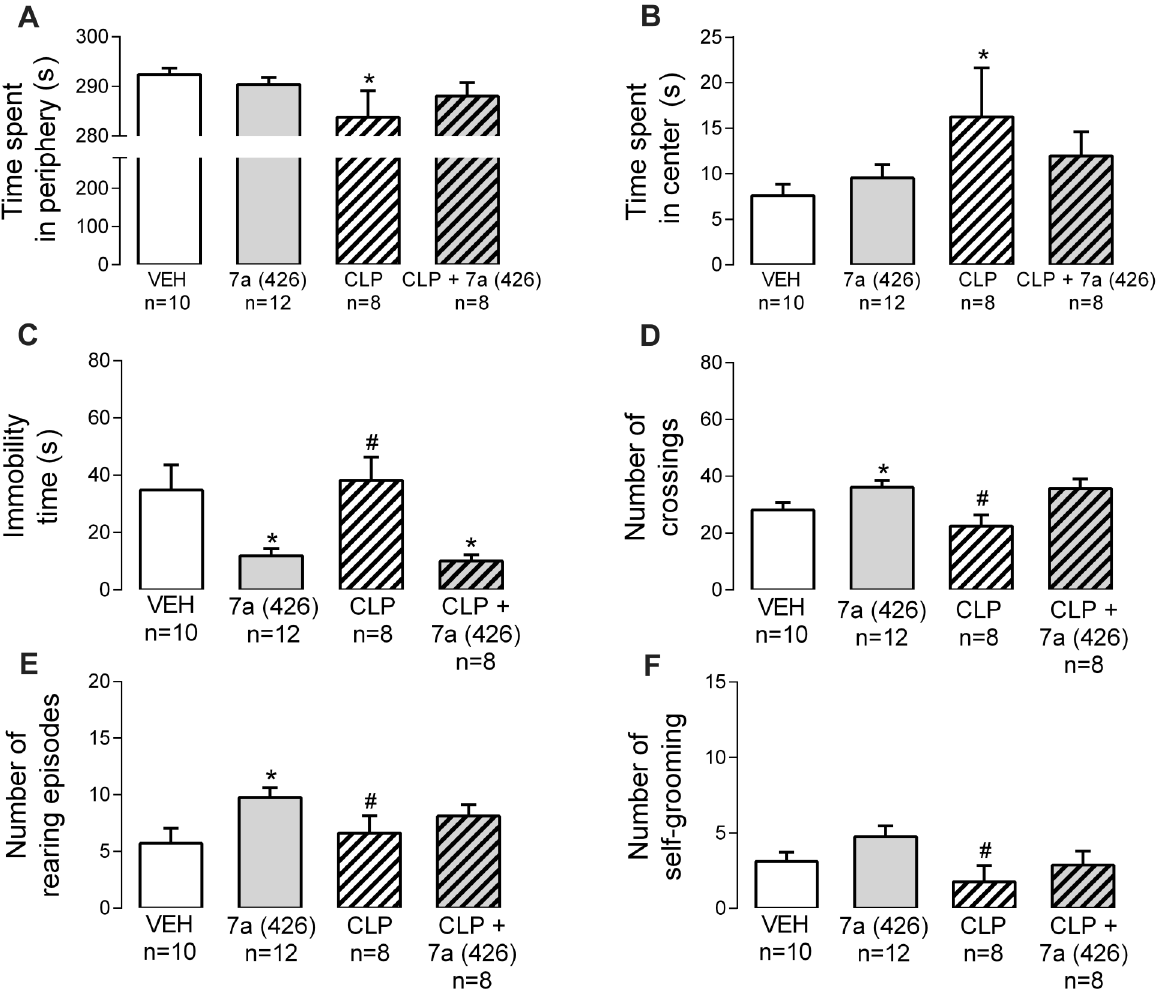
Figure 8. Contribution of dopaminergic receptors (as revealed by the antagonism with chlorpromazine) to the effects evoked by Bj-PRO- 7a on locomotion/exploration in the open fi eld. A , Time spent in periphery; B , Time spent in center; C , Immobility time; D , Number of crossings; E , Number of rearing episodes; F , Number of self-grooming episodes. Experimental groups: VEH: vehicle (0.9% NaCl); 7a (426): Bj-PRO-7a (426 nmol/kg); CLP: chlorpromazine (2 mg/kg); CLP + 7a (426): co-administration of CLP and Bj-PRO-7a (426 nmol/ kg). Data are reported as means ± SE. *P o 0.05 vs vehicle; # P o 0.05 vs 7a (426) (one-way analysis of variance followed by Fisher ’ s post hoc